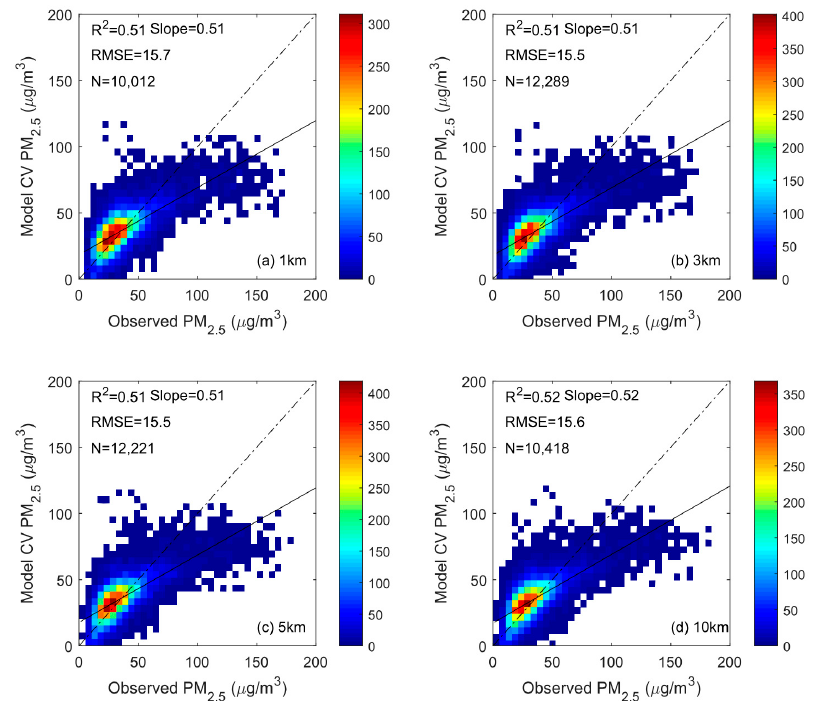
Figure 5. Scatter plots of 10-fold cross validation (CV) results for the land-use regression (LUR) model at the resolutions of ( a ) 1, ( b ) 3, ( c ) 5 and ( d ) 10 km. The color bar represents the counts of samples. R 2 , RMSE and N are the coefficient of determination, root-mean-square error and number of samples, respectively. The dashed line stands for the 1:1 line.